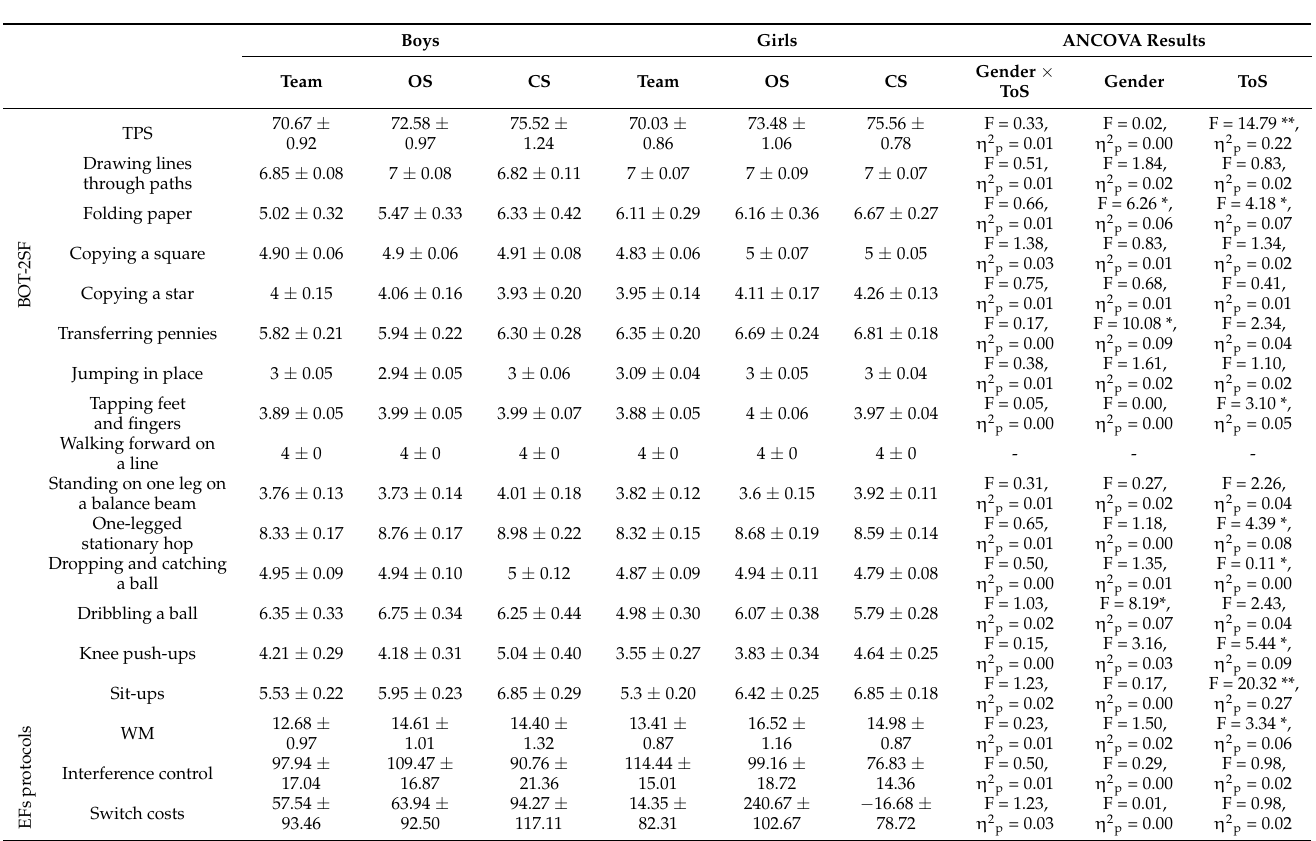
Table 2. Estimated marginal means (+ standard errors) and ANCOVA results for BOT-2SF and EF scores by gender and type of